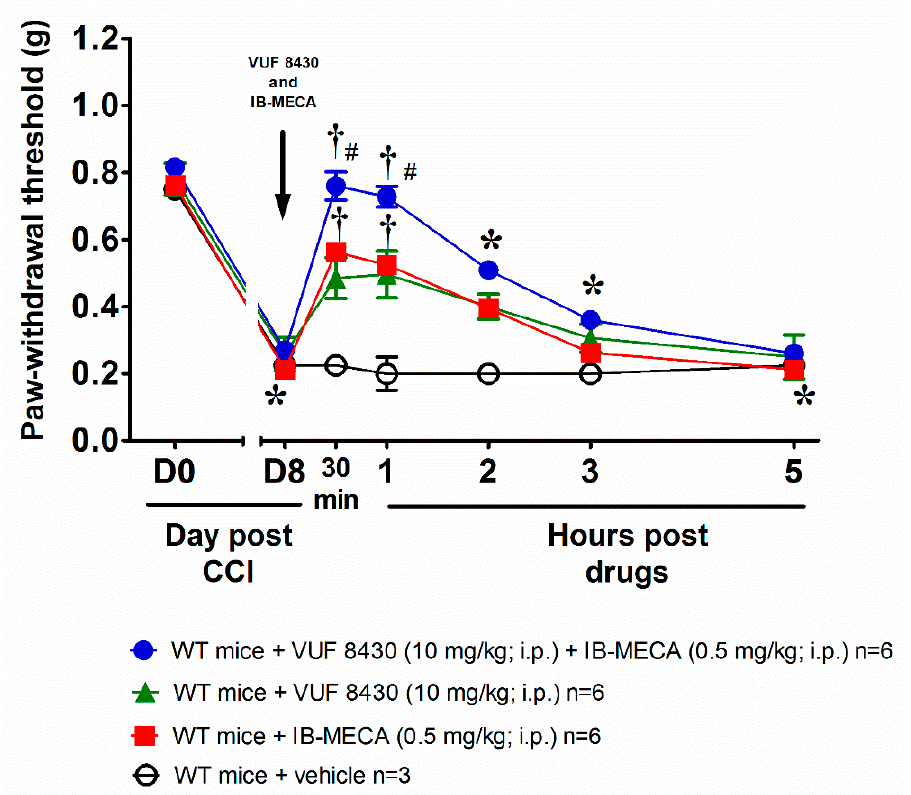
Figure 1. Anti-allodynic effect of A 3 adenosine receptor (A 3 AR) and H 4 histamine receptor (H 4 R) agonists on Chronic Constriction Injury (CCI)-induced neuropathic pain in wild type (WT) mice. Sciatic nerve ligation was performed 8 days before the acute injection of IB-MECA (0.5 mg/kg, i.p.), VUF 8430 (10 mg/kg, i.p.) or the combination of both (VUF 8430 10 mg/kg + IB-MECA 0.5 mg/kg). The response to a non-noxious mechanical stimulus was assessed by the von Frey test. Measurements were performed before and 30 min, 1 h, 2 h, 3 h and 5 h after compounds administration. Values reported in the graph are referred to the tests conducted on the ipsilateral paw. Data are mean ± SD for n mice per group; * p < 0.05 vs. Day 0 by two-way ANOVA with Dunnett’s test; † p < 0.001 vs. Day 8 by two-way ANOVA with Tukey’s comparisons; # p < 0.001 vs. WT + VUF 8430 (10 mg/kg) and WT + IB-MECA (0.5 mg/kg) by two-way ANOVA with Tukey’s